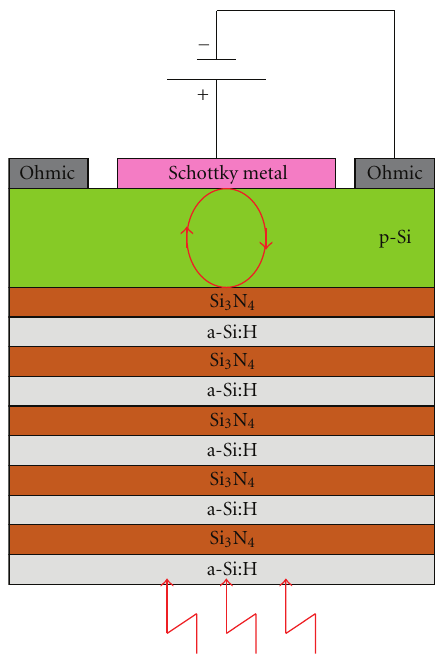
Figure 2: Schematic cross-section of the proposed photodetector.